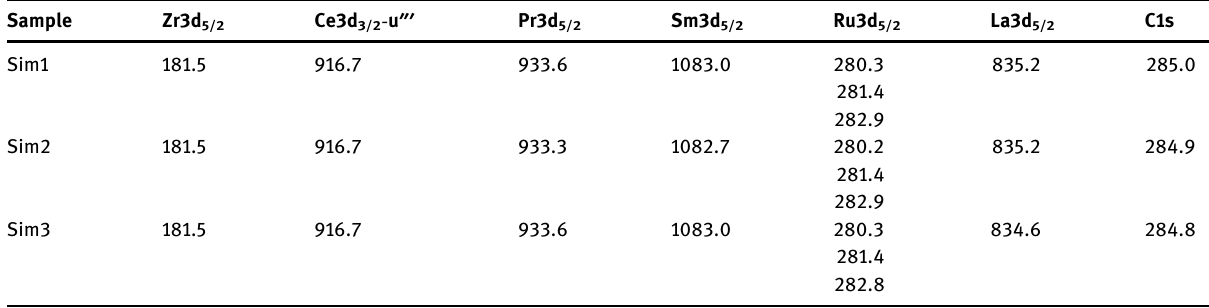
Table 4: Binding energies ( eV )